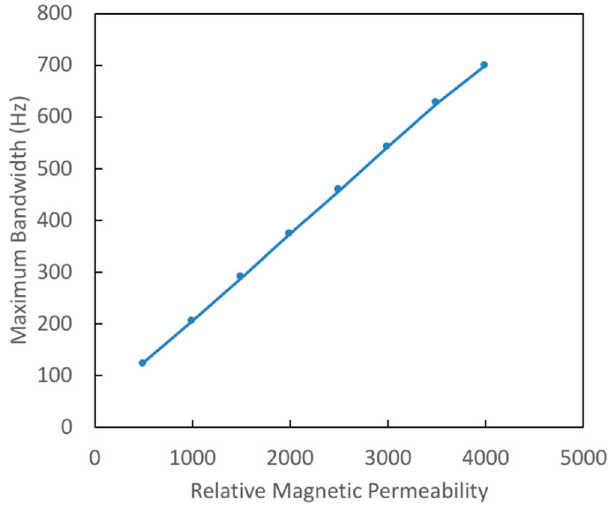
Figure 7. Pareto-optimal curve showing maximum achievable bandwidth as a function of relative magnetic permeability µ r of the actuator’s ferromagnetic material.